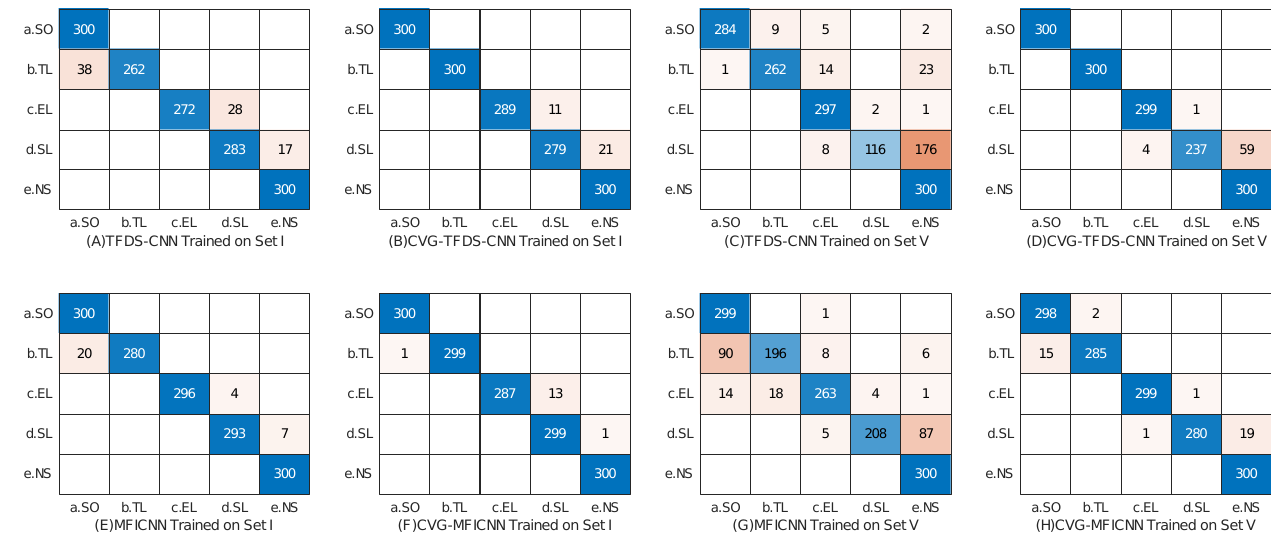
Figure 16. Testing confusion charts of models trained using the TFDS-CNN, CVG-TFDS-CNN, MFICNN, and CVG-MFICNN methods based on training sets I and V.